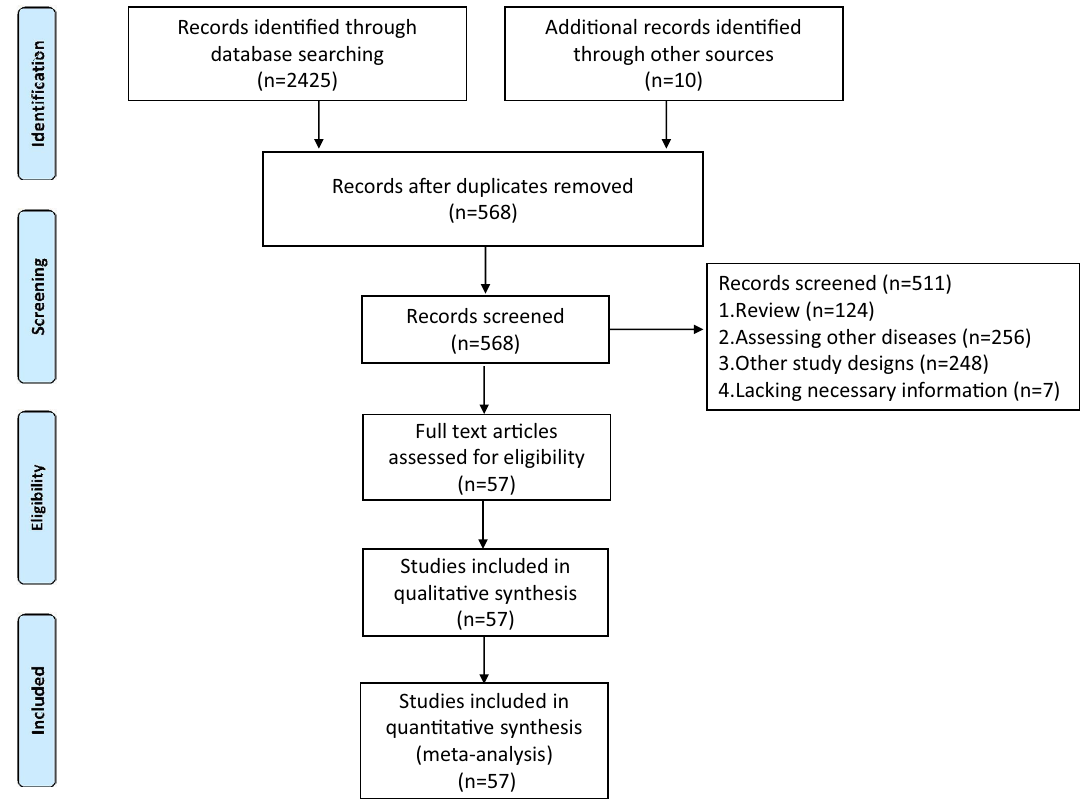
Figure 1. Flow diagram of study selection for inclusion in this meta-analysis.